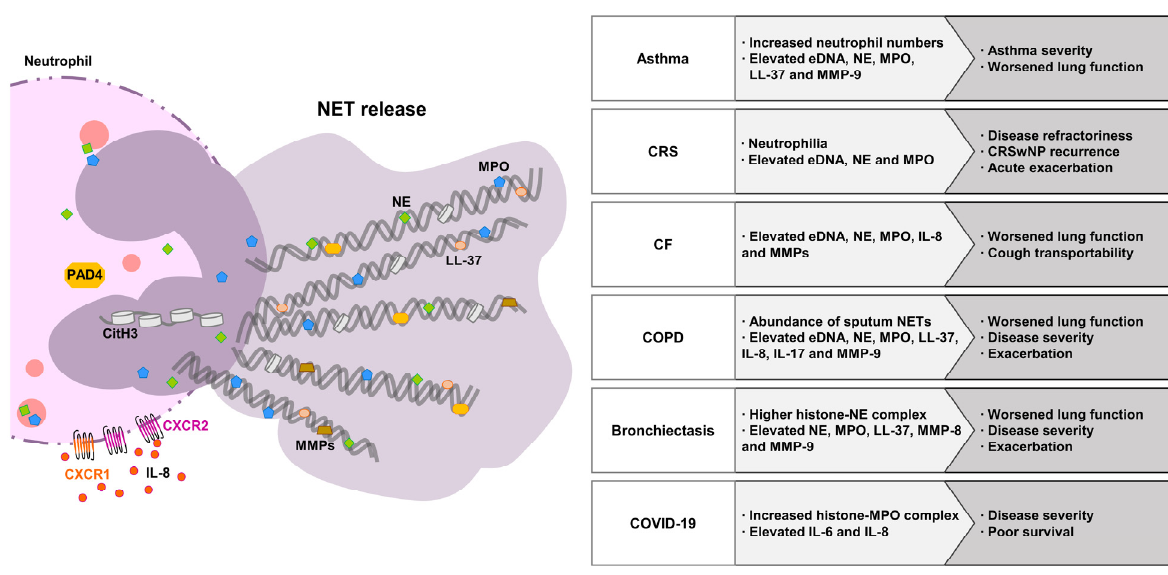
Figure 2. Clinical implications for neutrophil extracellular trap (NET) components in airway diseases. Elevated NET components have been implicated in the pathogenesis of airway diseases. NET: neutrophil extracellular trap; eDNA: extracellular DNA; NE: neutrophil elastase; MPO: myeloperoxidase; PAD4: protein arginine deiminase 4; CitH3: citrullination of histone H3; IL: interleukin; MMP: matrix metalloproteinase; CXCR: C–X–C motif chemokine receptor; CRS: chronic rhinosinusitis; CF: cystic fibrosis; COPD: chronic obstructive pulmonary disease; COVID-19: coronavirus disease 2019.